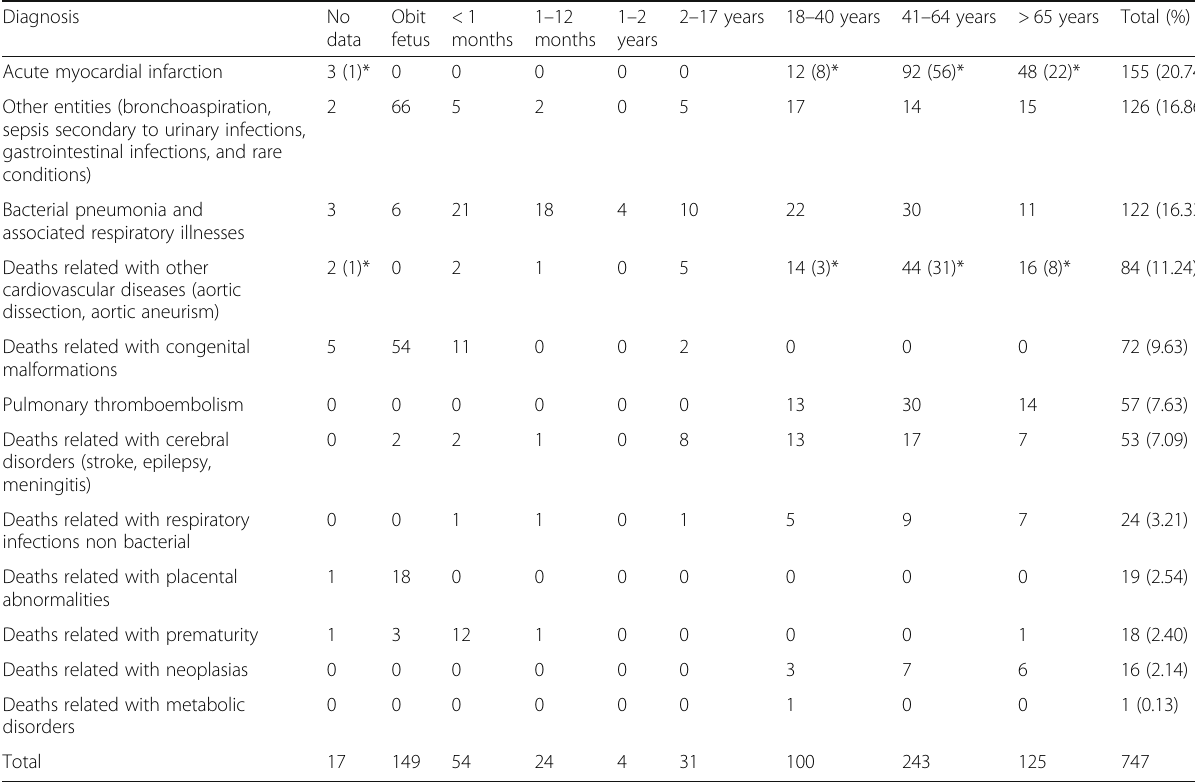
Table 2 Main anatomical pathology diagnoses by age group Diagnosis No